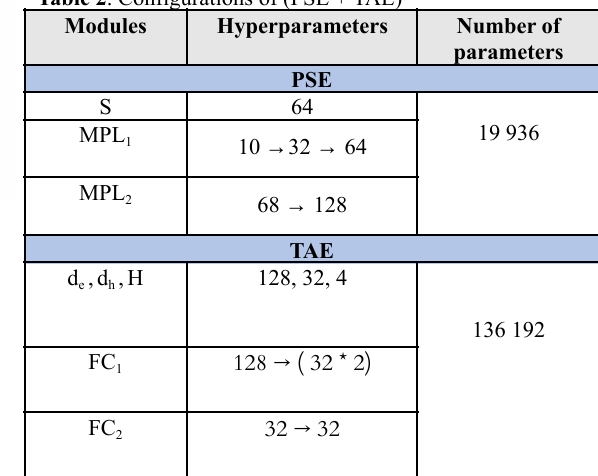
Table 2 . Configurations of (PSE +